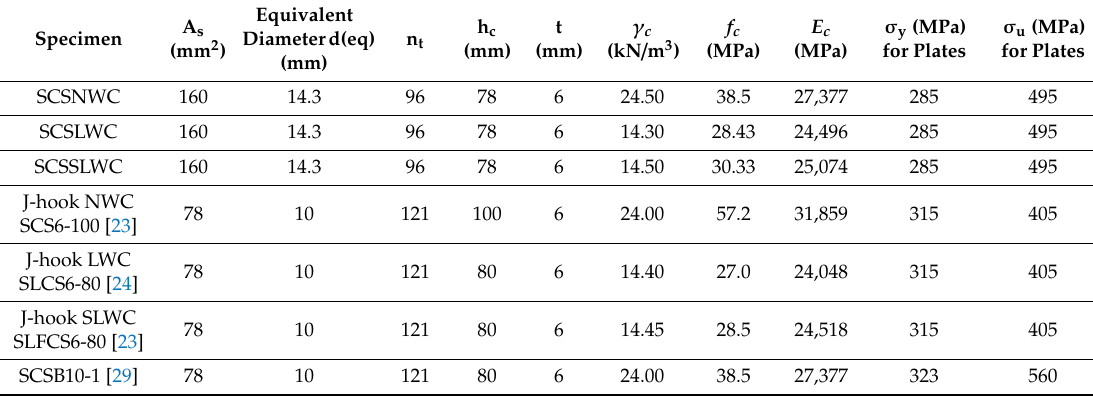
Table 8. Specimens properties of this study and